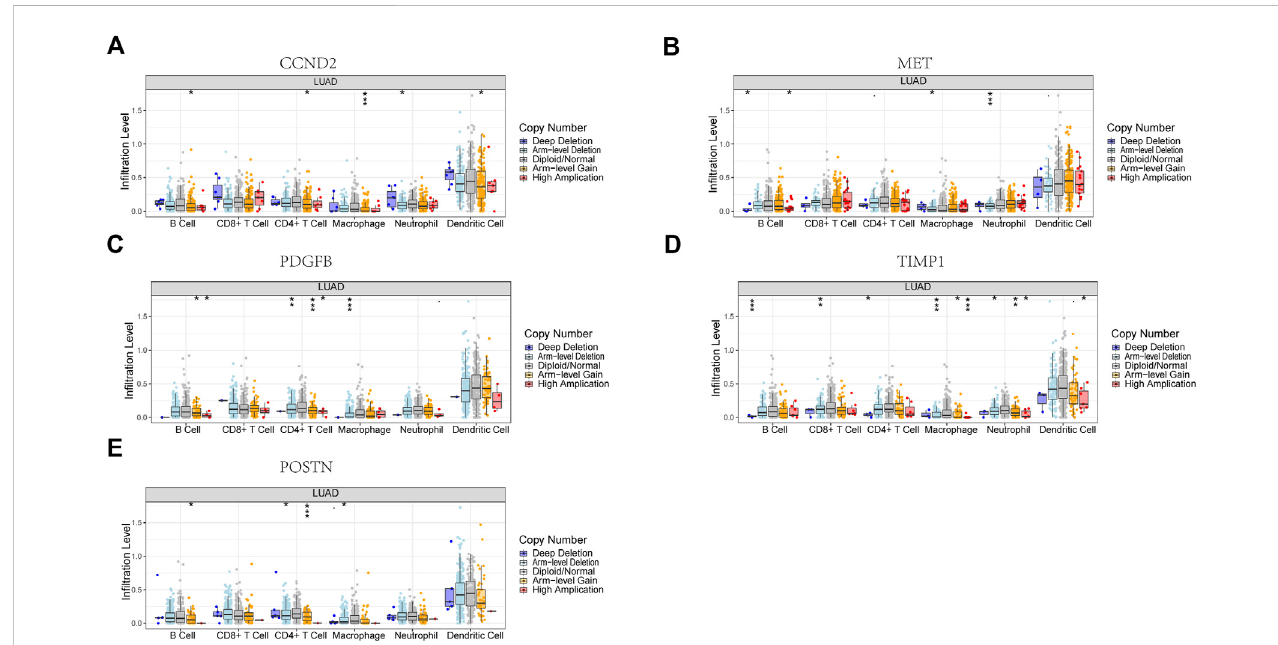
FIGURE 10 Association between CNV and immunity in 5 model genes. (A) CCND2. (B) MET. (C) PDGFB. (D) TIMP1. (E) POSTN. * p < 0.05, ** p < 0.01, *** p < 0.001.